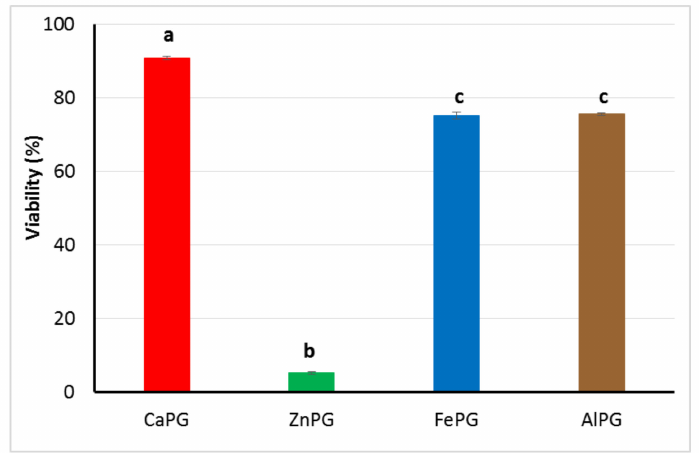
Figure 9. Effect of CaPG, ZnPG, FePG, and AlPG beads on viability of human peripheral blood mononuclear cells (hPBMCs). Control (cells in the presence of culture medium) corresponded to 100% viability. Different letters indicate significant differences between pectin gel beads prepared with different cations ( p <